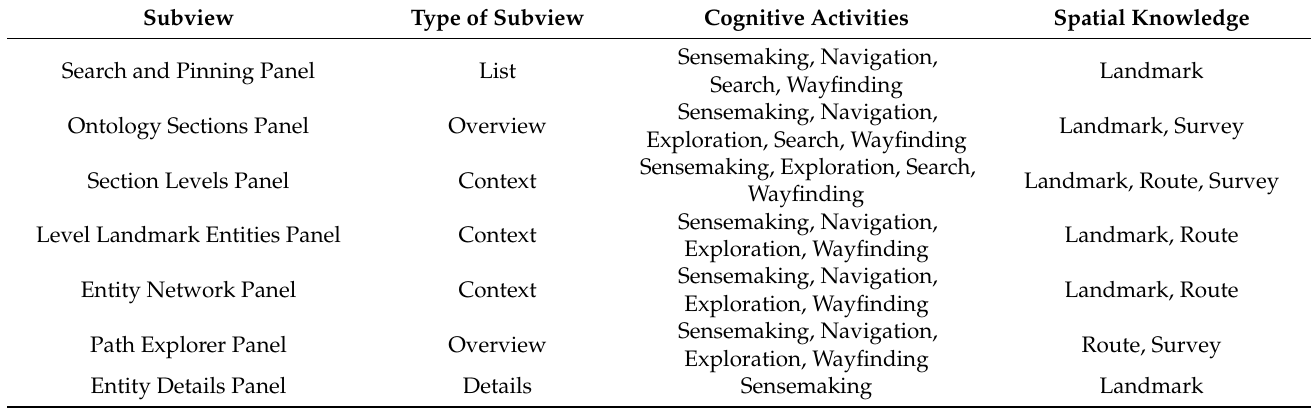
Figure 8. An overall view of the PRONTOVISE ontology visualization system, which has seven subviews: Search and Pinning Panel subview ( a ); Ontology Sections Panel subview ( b ); Section Levels Panel subview ( c ); Level Landmark Entities Panel subview ( d ); Entity Network Panel subview ( e ); Path Explorer Panel subview ( f ); and Entity Details Panel subview ( g ). Table 5. A summary of the subviews of PRONTOVISE, describing their subview type, supported cognitive activities, and their relationship to the stages of cognitive map formation.